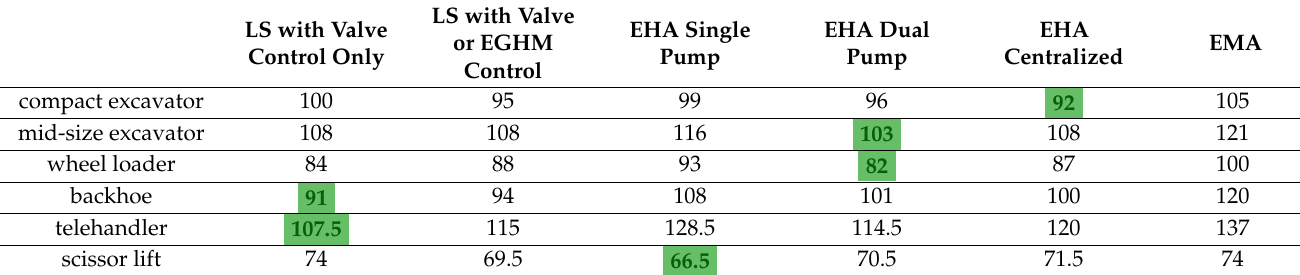
Table 3. Mismatch values for all 36 actuator-HDMM matches and weight matrix W = W 0 ⋅ W costs . The best values for each HDMM type have been marked green.